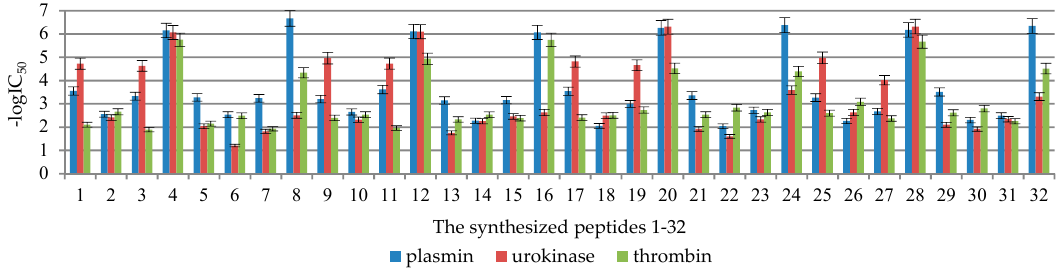
Figure 1. Inhibition of plasmin, urokinase, and thrombin by 1–32 peptides presented as -logIC 50.